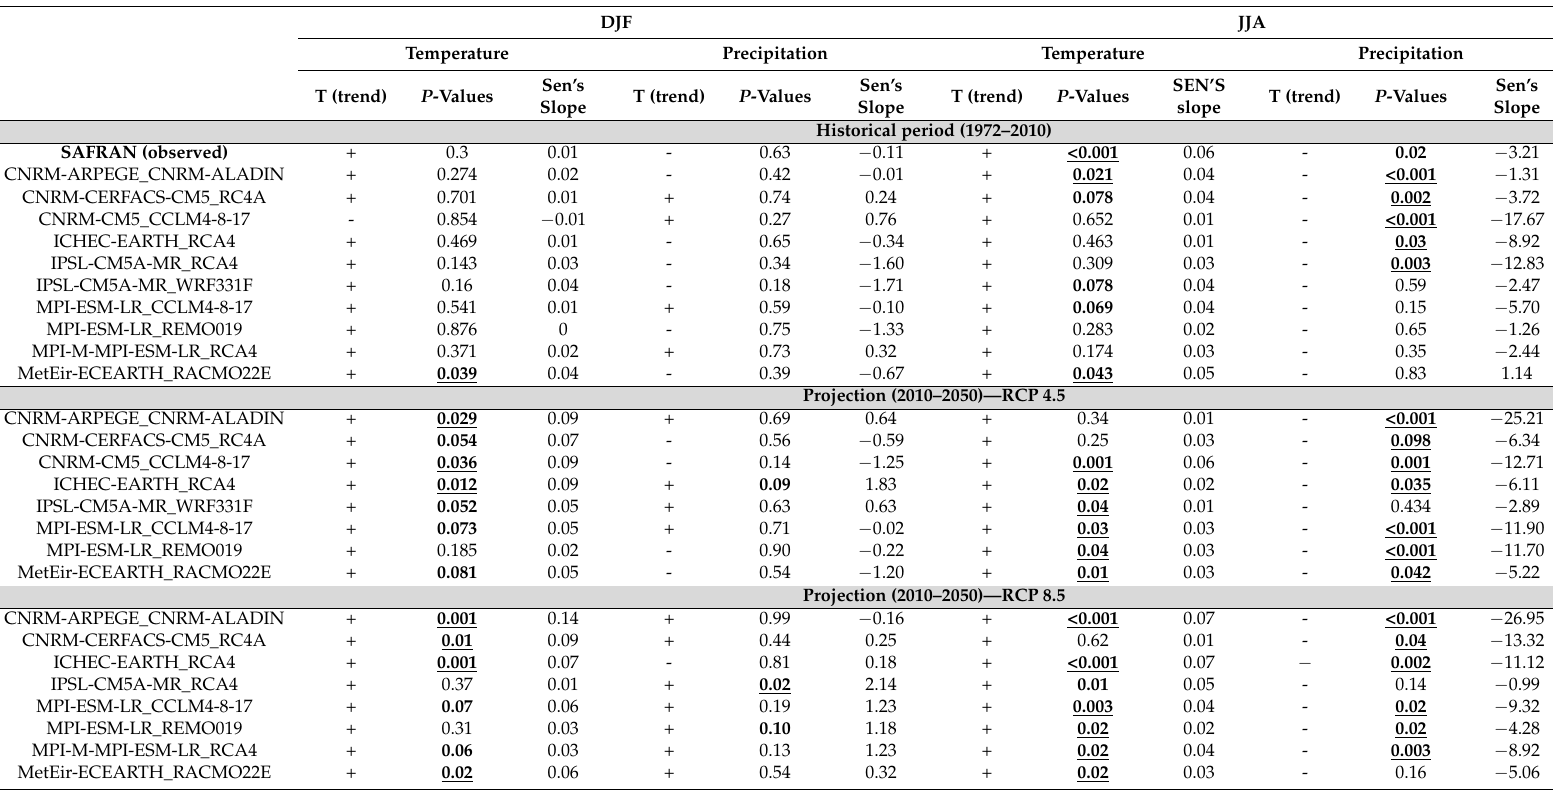
Table 5. Trend in precipitation and temperature over winter (DJF) and summer (JJA) seasons at watershed scale, for SAFRAN (historical period) and the climatic ensemble (historical and projected period). Bold numbers are significant trend considering α = 0.1 and underlined numbers considering α =